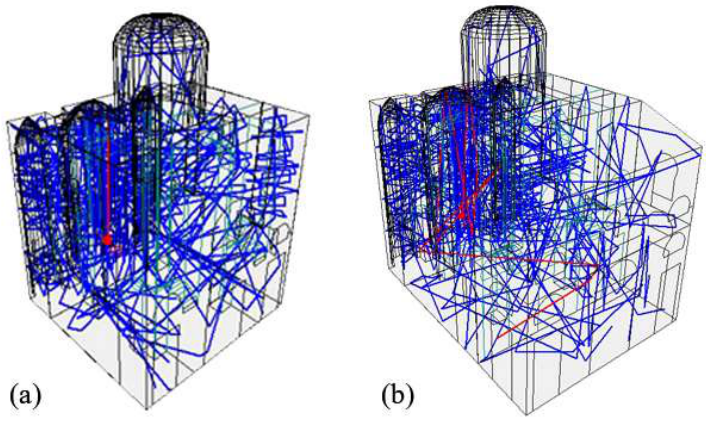
Figure 9. Ray tracing model of Bell Church from ( a ) Phase I; ( b ) Phase II.